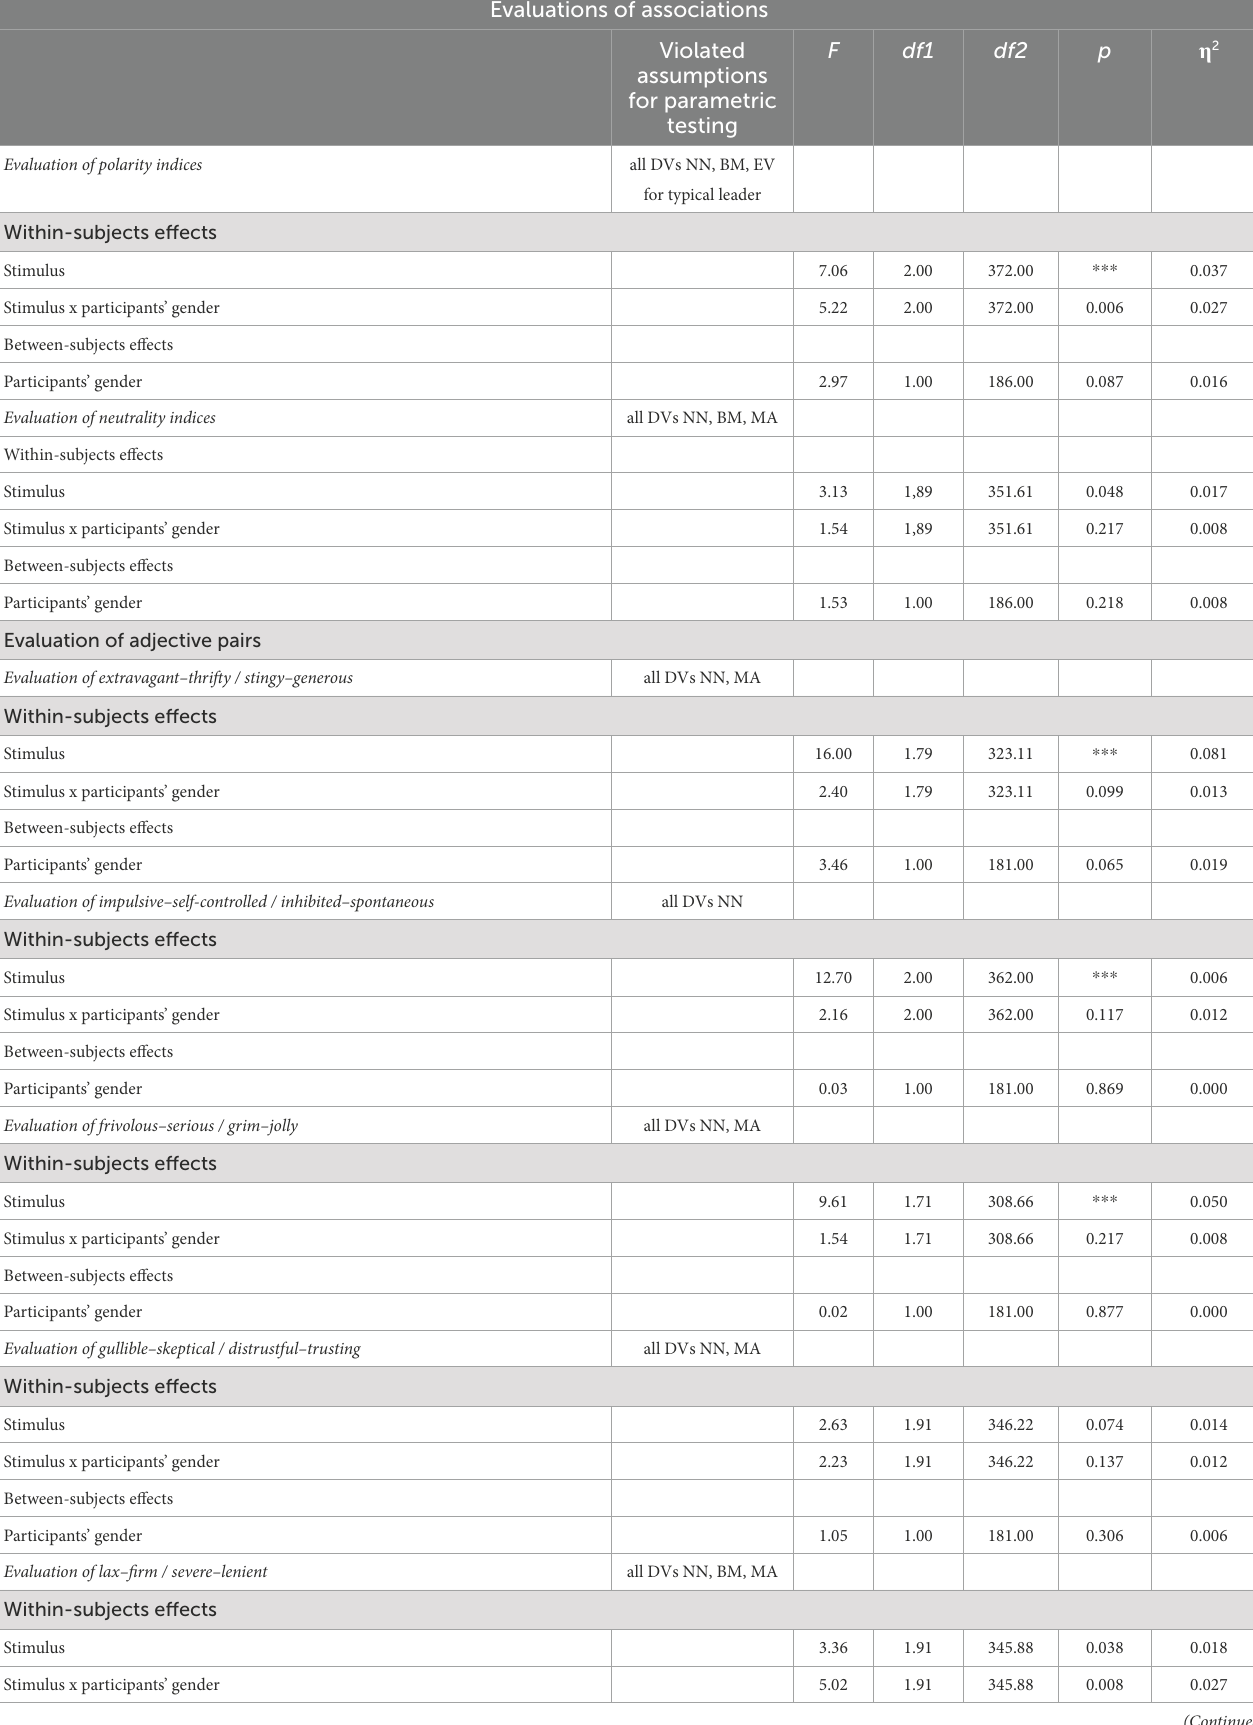
TABLE 3 Test statistics of tests on evaluations of associations and evaluation of adjective pairs.